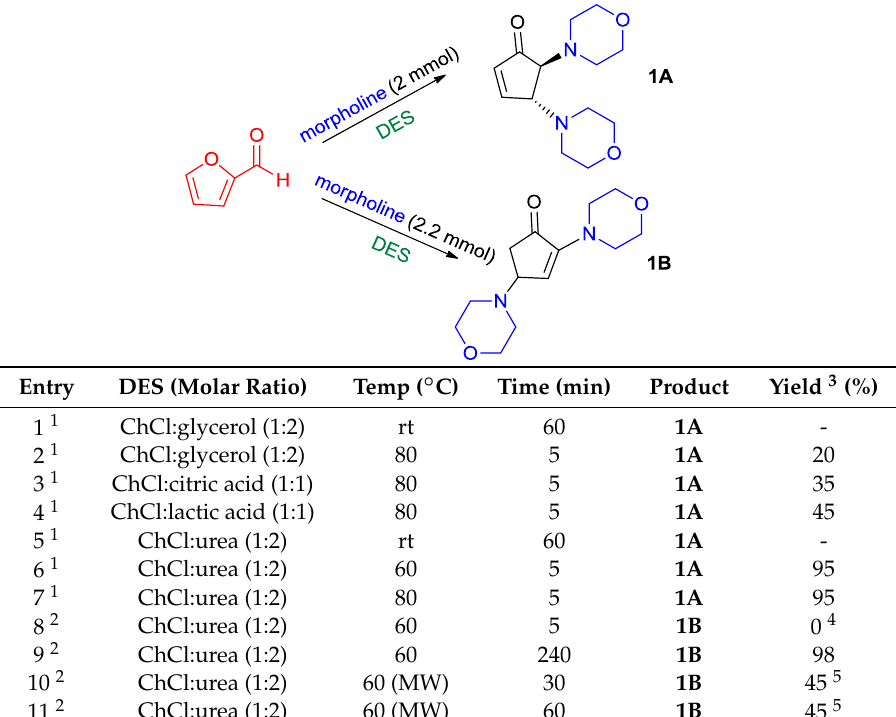
Table 1. Optimization of the reaction conditions in model reaction 1,2 .